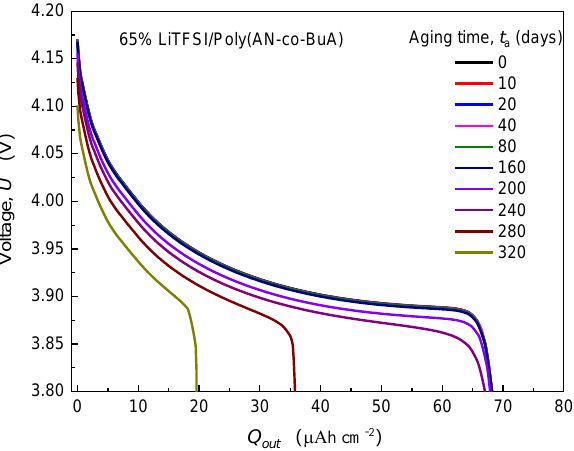
Figure 3. Effect of physical aging on the discharge curve ( 𝑈 − 𝑄 𝑜𝑢𝑡 ) at 1C rate.